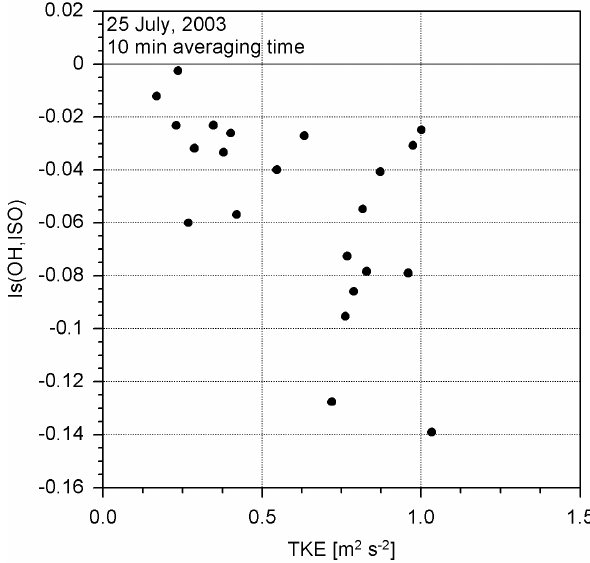
Figure 18. The correlation coefficient M 21 (see Eq. 17) as a func- tion of the two dominant terms nvar ( Iso ) IS and RE IS in the diag- nostic equation to determine I S (Eq. 16).